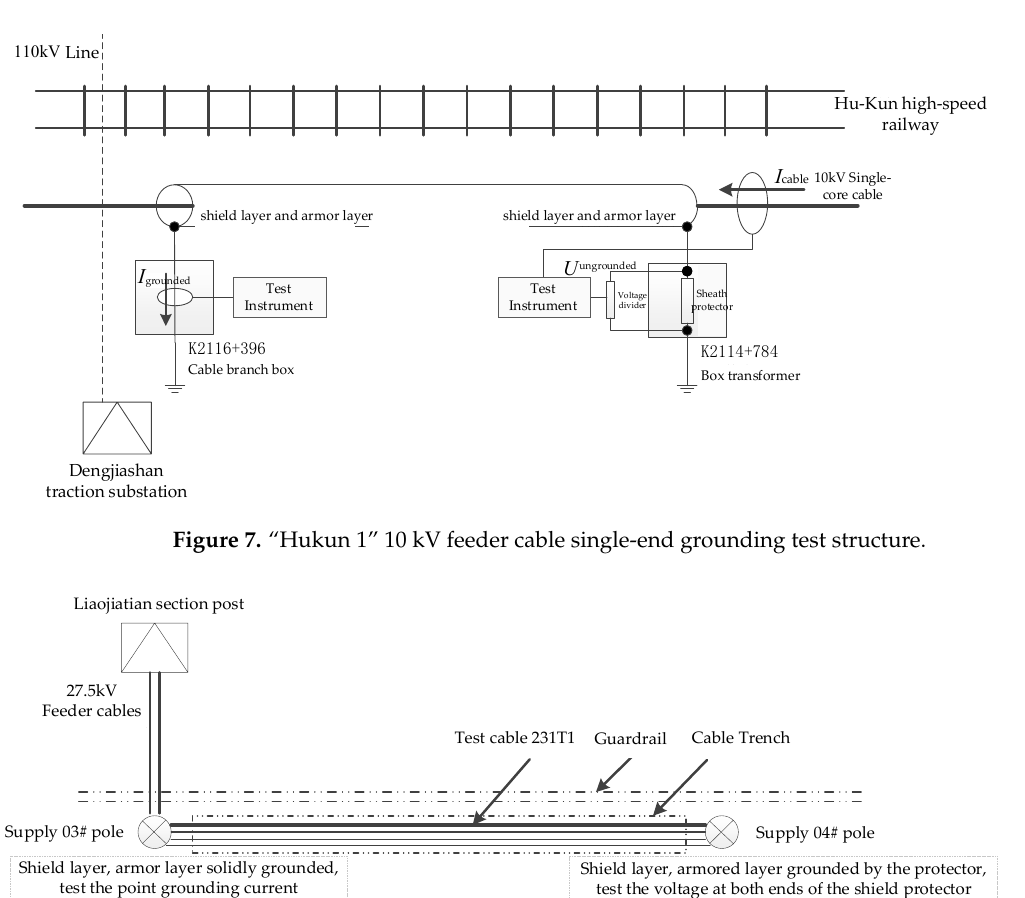
buried installation